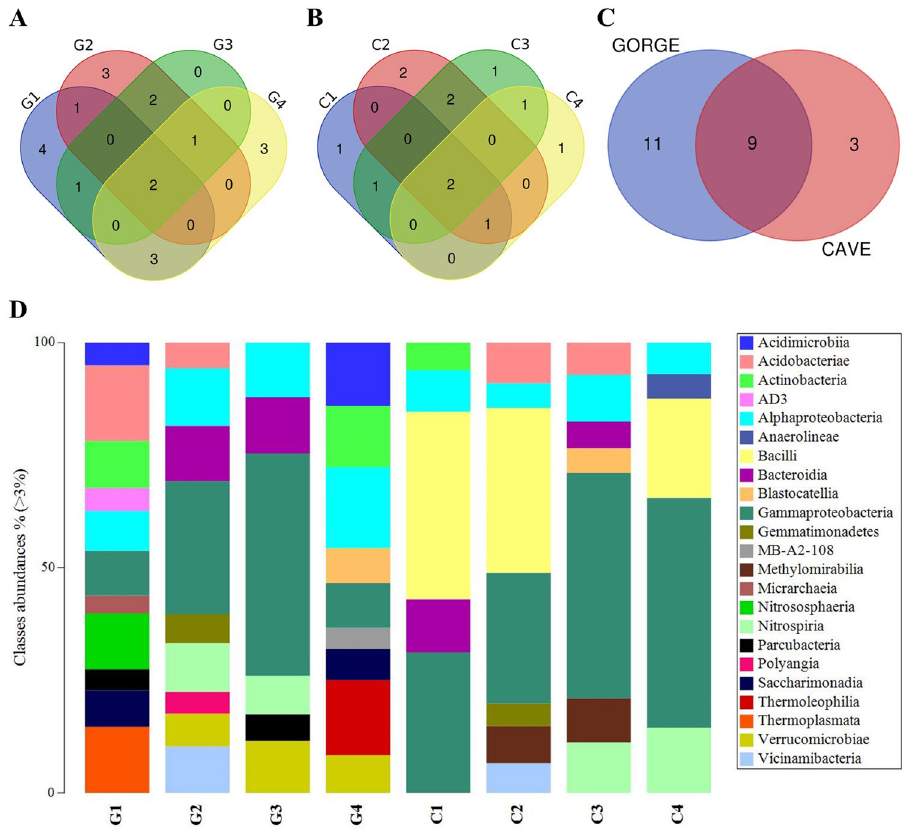
Figure 4. Venn diagrams and taxonomy barplot of ASVs at class level. Venn diagrams show common classes found within gorge ( A ) and cave ( B ) samples and between the two groups (gorge vs cave). Taxonomy barplot shows the abundances (%) of main classes in each sample ( D ) (cutoff